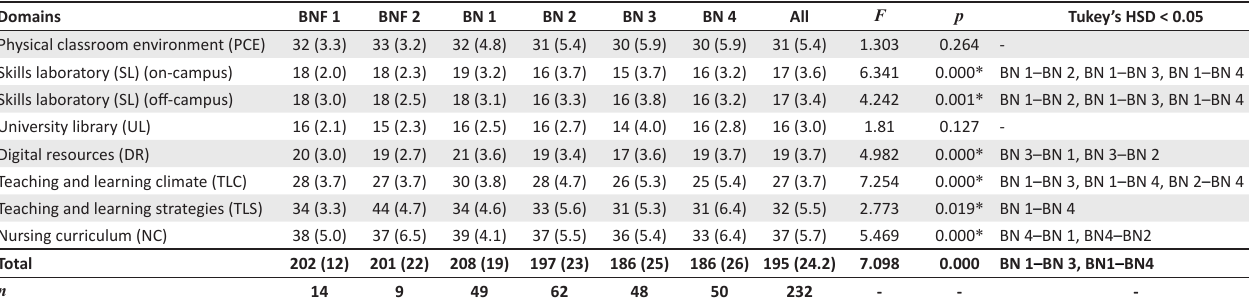
TABLE 2: Mean (standard deviation) and overall scores by year level. Domains BNF